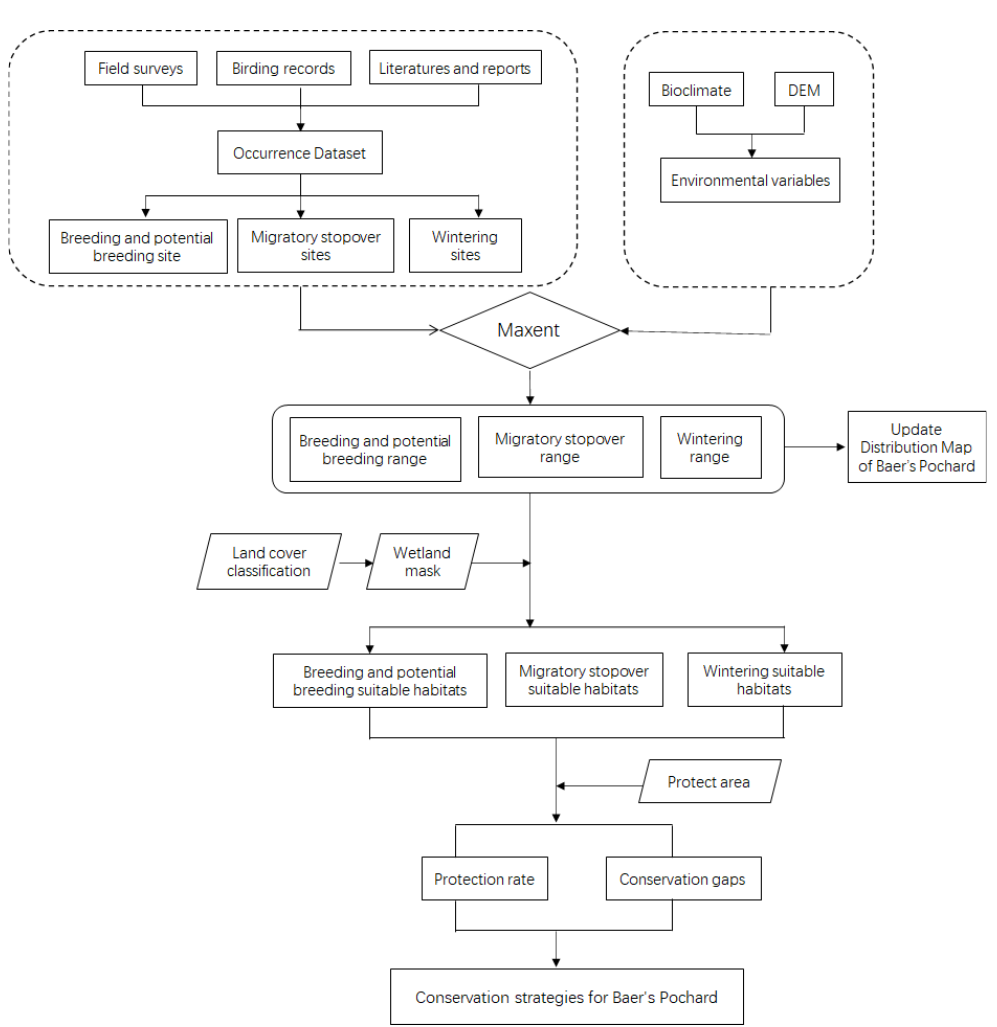
Figure 2. Flowchart showing the steps proposed for formatting effective Baer’s Pochard conserva- tion policy.